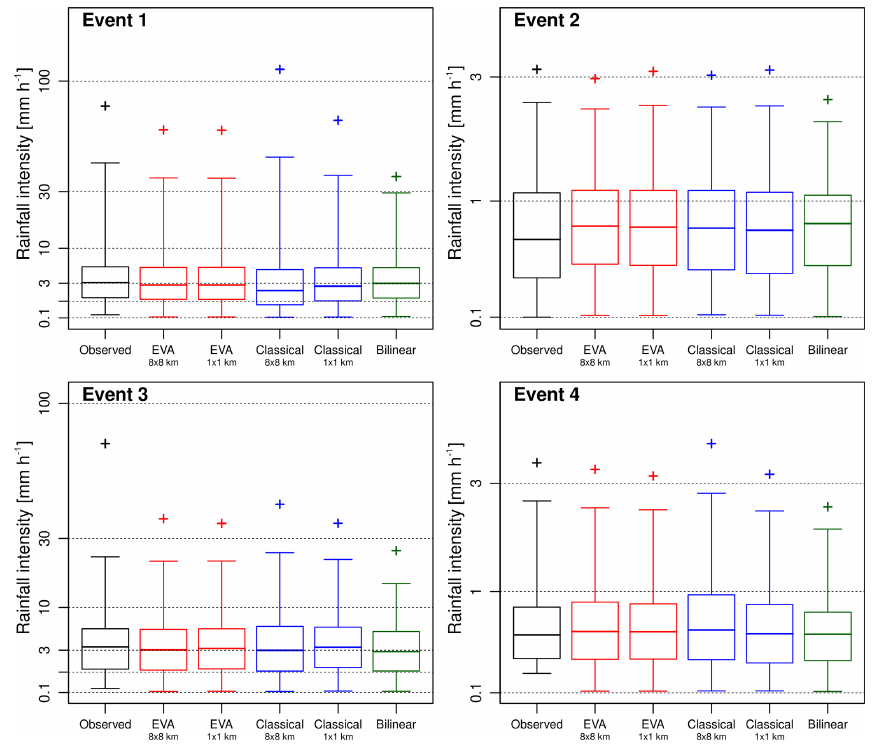
Figure 12. Observed versus downscaled rainfall rates for the first four events in the database and a downscaling ratio of 64 (i.e., input resolution of 8km × 8km and target resolution of 1km × 1km). The boxplots denote the 1%, 25%, 50%, 75%, and 99% quantiles of rainfall rates (given occurrence). The crosses represent the 99.9% quantiles among 100 different random realizations. The labels of 8 × 8km and 1 × 1km denote the resolution of the input data used to estimate the sample cascade